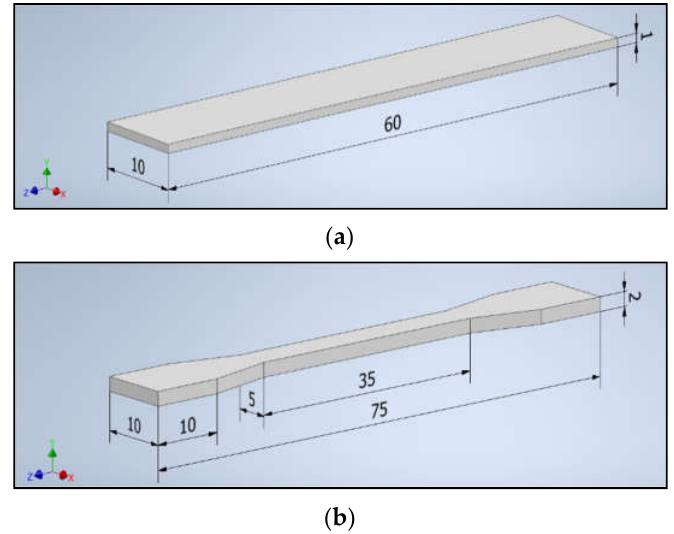
Figure 2. The dimensions of the samples: ( a ) a bar and ( b ) a paddle.